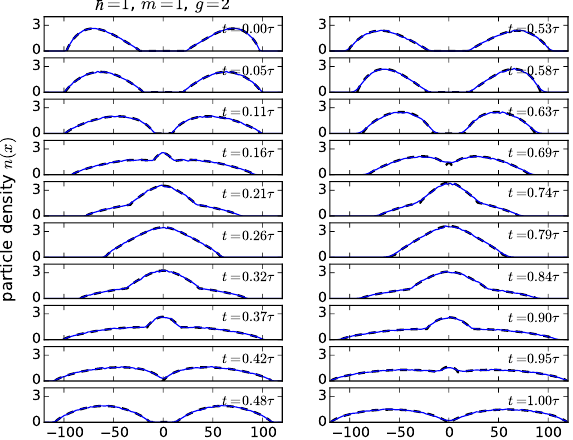
Figure 4: Lieb-Liniger gas at zero temperature released from a double-well potential to a harmonic trap V ( x ) = m ω 2 x 2 / 2, on one full period τ = 2 given in the text. Two methods for solving Eq. (3) are compared: zero-entropy GHD (dashed black curve), and the flea gas